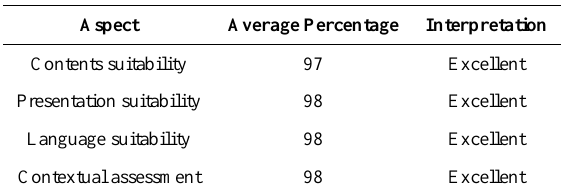
Table 2. Expert validation result on training topics